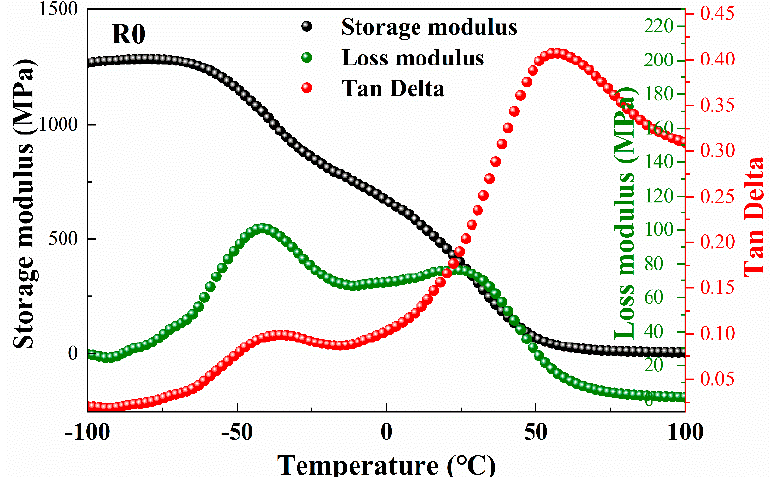
Figure 3. The E ′ , E ″ and Tan δ curves of R0 propellant. In order to obtain the effect of RDX on the glass transition temperature of propellants more intuitively, the values of T α and T β are given in Figure 4 and Table S2 in the support- ing information. T β is a parameter of the adhesive system of propellants, which is related to the molecular motion of the side group in NC. A lower T β means better molecular mobility of the NC/Bu-NENA system. Additionally, deformation could occur more readily for adhesive systems at low temperature. It is obvious that both T α and T β increased along with the enrichment of the RDX concentration. It may have been mainly caused by the hindrance to molecular motion of the adhesive from RDX as mentioned above.